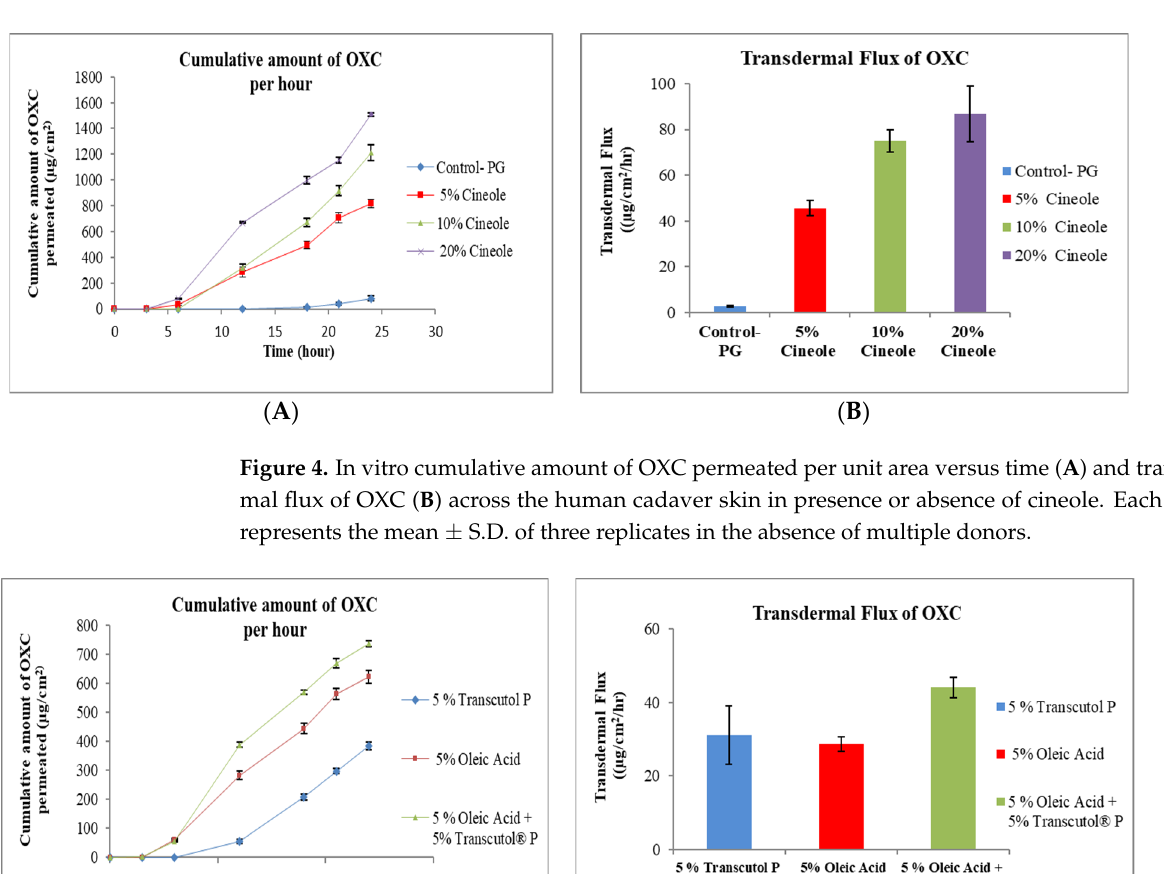
Figure 3. In vitro cumulative amount of OXC permeated per unit area versus time ( A ) and transdermal flux of OXC ( B ) across the human cadaver skin in presence or absence of N -Methyl 2-Pyrrolidone. Each point represents the mean ± S.D. of three replicates in the absence of multiple donors.